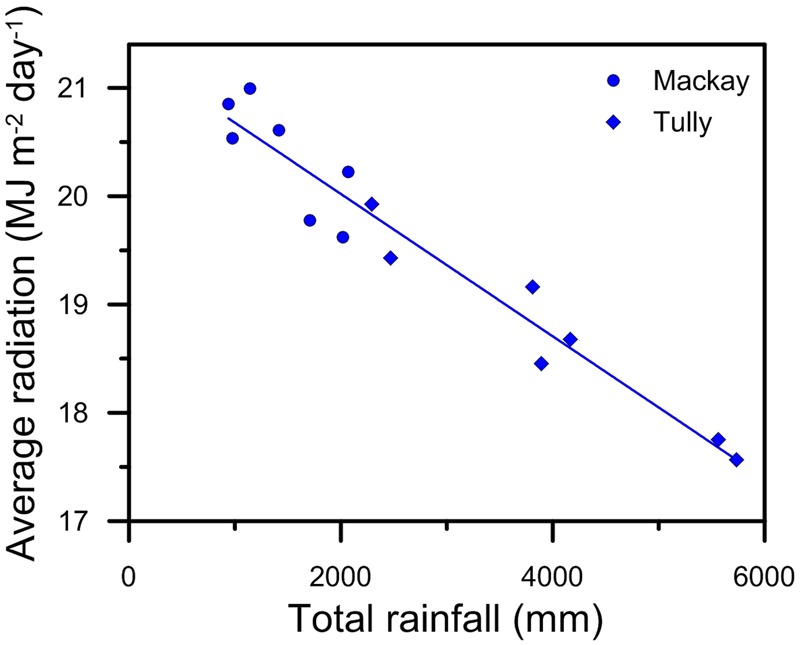
The variation in average daily radiation with rainfall for the crops simulated in Figure 5.